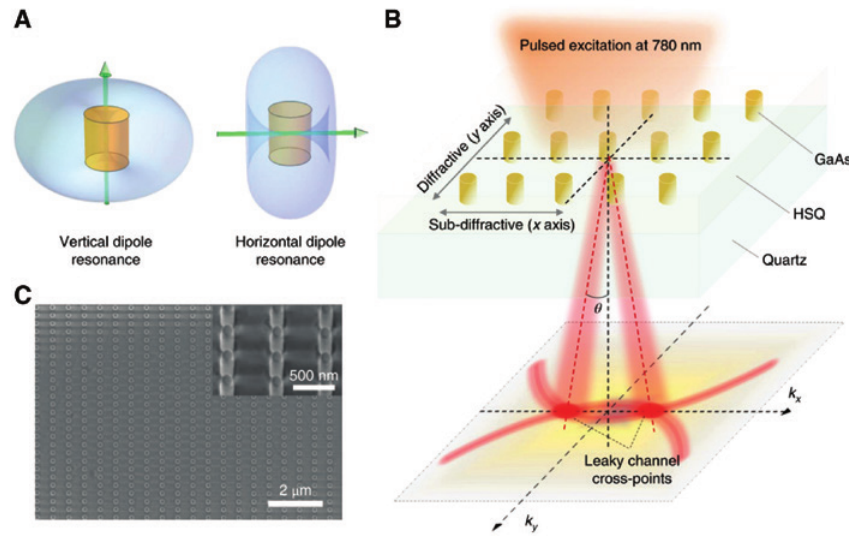
Figure 9: Unidirectional BIC laser. (A) Resonances in GaAs nanoparticles. (B) Sketch of the nanoparticle lattice growth on a quartz substrate embedded in hydrogen silsesquioxane resist. (C) Scanning electron microscope (SEM) image of the metasurface. Adapted with permission from